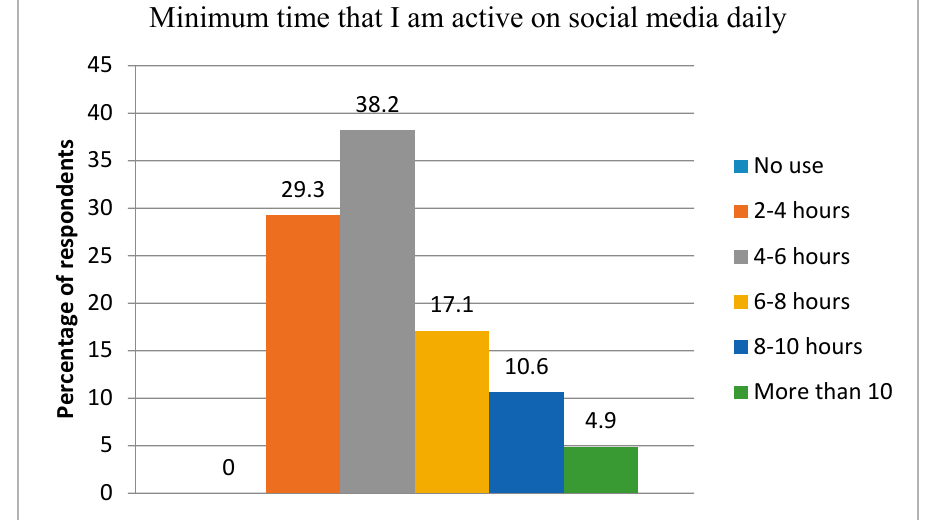
Figure 2. Minimum time of being active at Social Media daily.